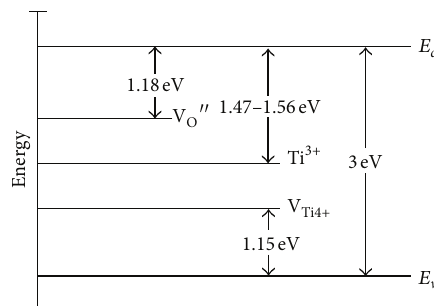
Figure 7: The energy levels of OTDs in TiO 2 [5].